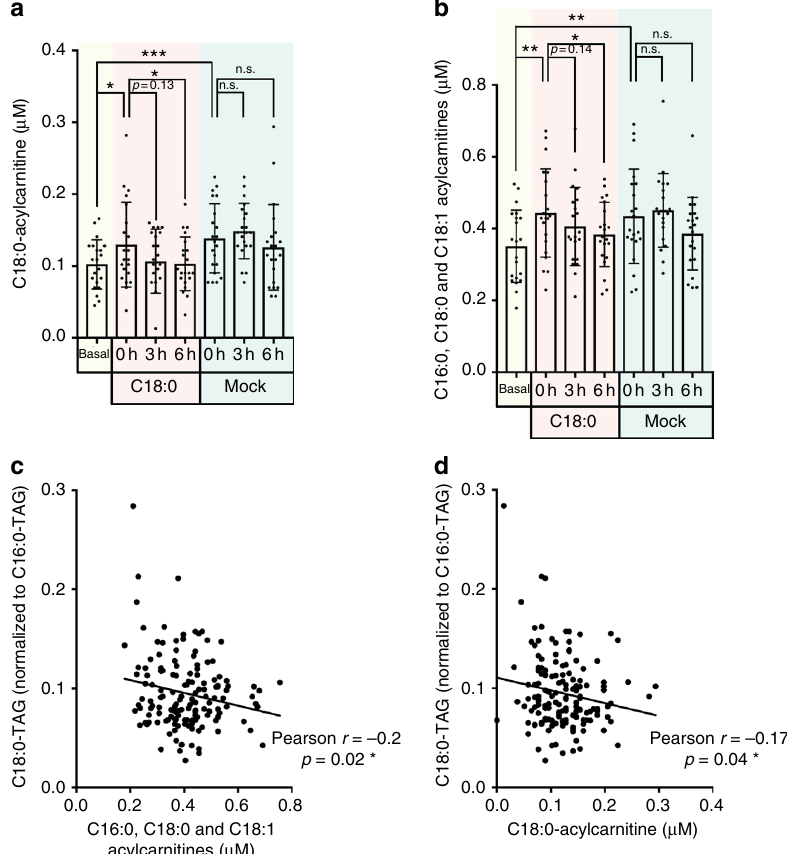
Fig. 3 Dietary C18:0 intake activates fatty acid beta-oxidation in vivo. a , b Serum levels of a C18:0-acylcarnitine or b long-chain-fatty-acid-acylcarnitines, markers for reduced fatty-acid beta-oxidation, drop upon dietary intake of C18:0. Note that the non-signi fi cant drop at 6 h in both C18:0 and mock conditions can be due to eating lunch after the 3 h timepoint. ( n = 21 subjects, error bars = std. dev. * p ≤ 0.05, *** p < 0.001 by t -test.) c , d Serum levels of c C18:0-acylcarnitine or d long-chain-fatty-acid-acylcarnitines, markers for reduced fatty-acid beta-oxidation, anti-correlate with serum C18:0-TAG levels across all subjects, timepoints, and dietary conditions. ( n = 21 subjects × 7 timepoints = 147 serum